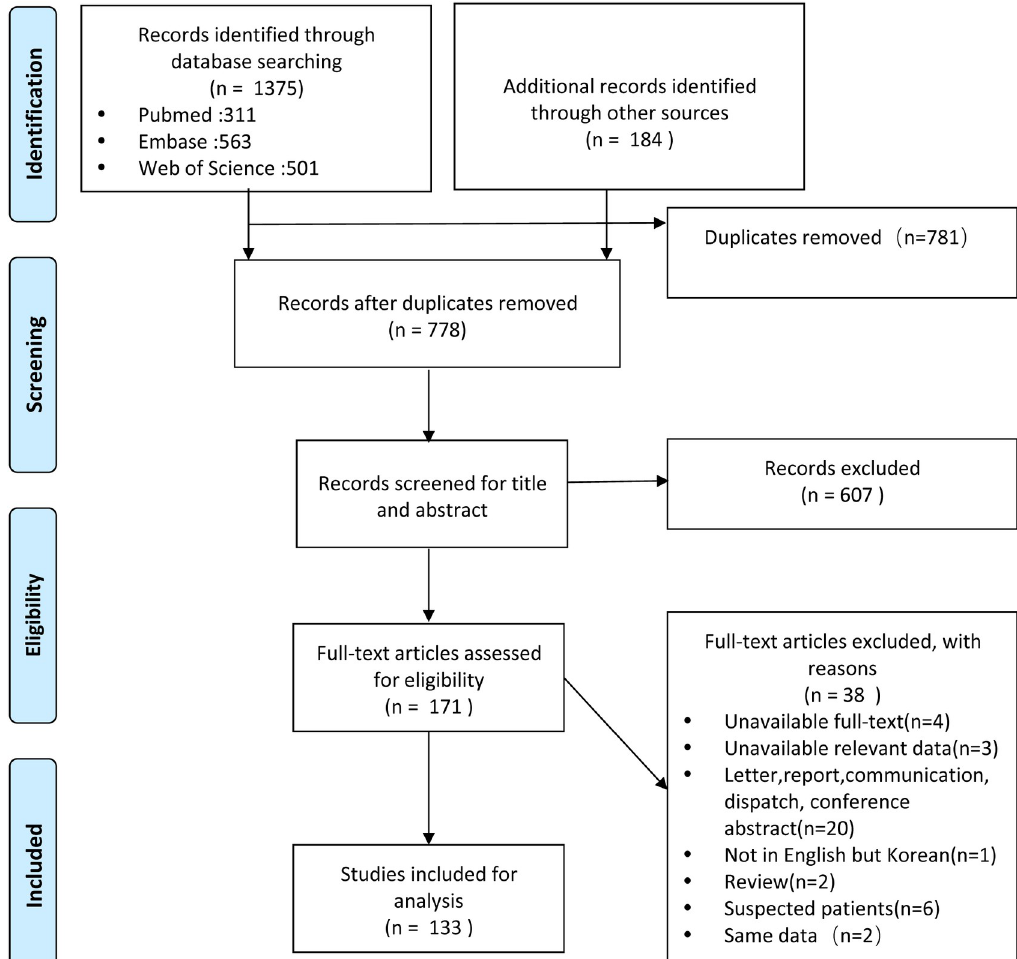
Fig 1. Flow diagram of publication selection